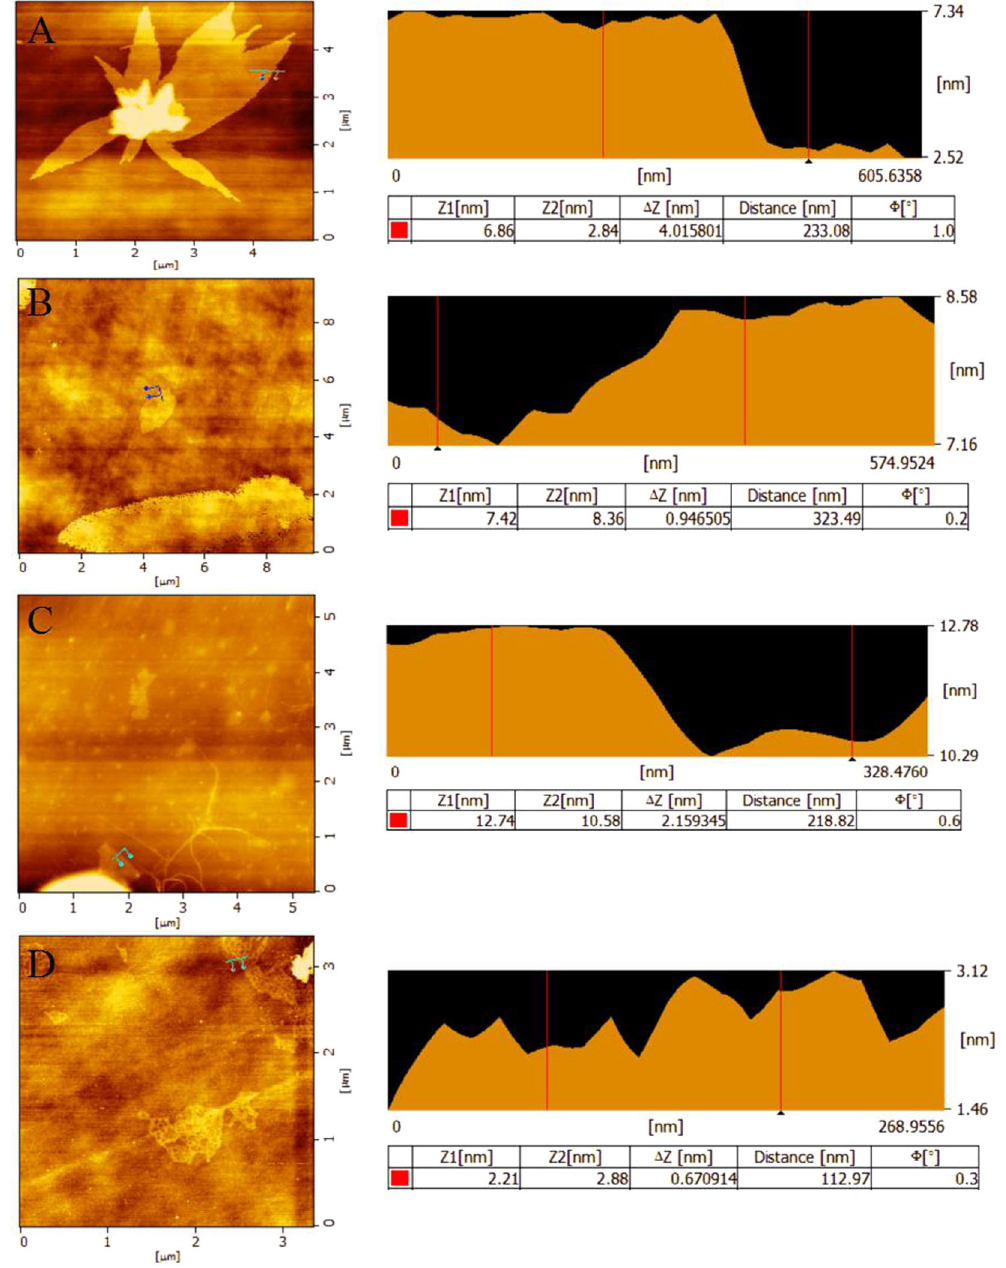
Figure 3. AFM images of GnPs ( A ), graphene ( B ), graphene oxide (powder) ( C ) and graphene oxide (sheet) ( D